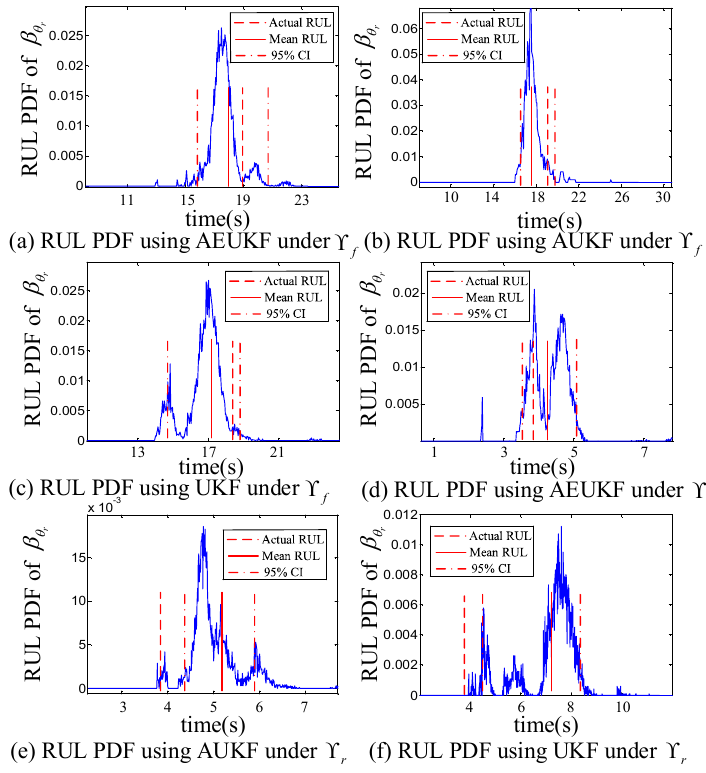
Figure 12. 𝛽 (cid:3087)(cid:3045) RUL prediction results. Figure 12. β θ r RUL prediction results. Table 5. Comparison of remaining useful life (RUL) prediction